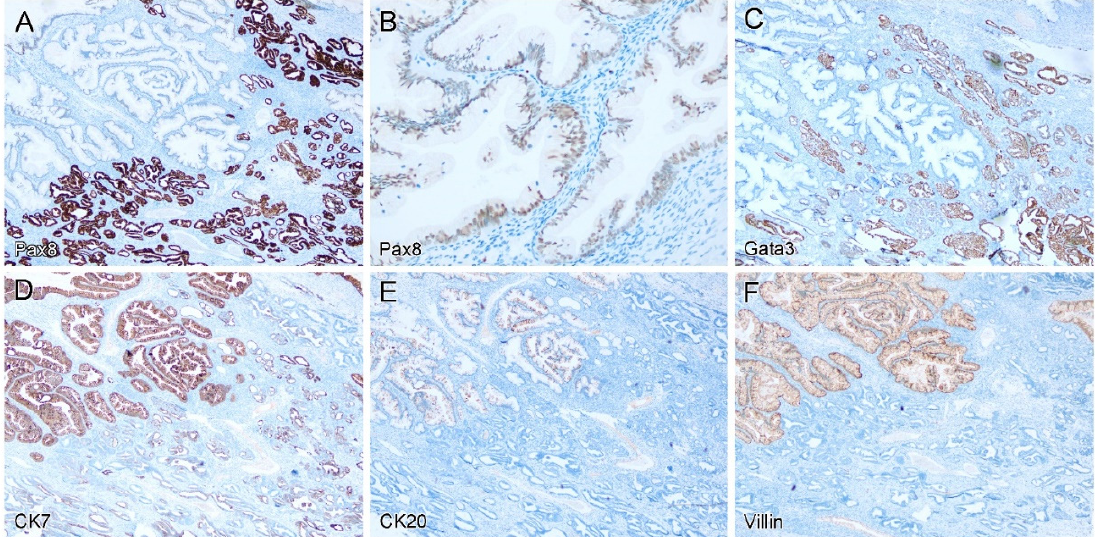
Figure 2. Immunohistochemical findings. The mesonephric-like proliferations/hyperplasia were diffusely positive for Pax8 ( A ), Gata3 ( C ), and focally positive for CK7 ( D ), but negative for CK20 ( E ) and villin ( F ). By contrast, the mucinous epithelium was weakly positive for Pax8 ( B ), diffusely positive for CK7 ( D ) and villin ( F ), focally positive for CK20 ( E ), but negative for Gata3 ( C ).